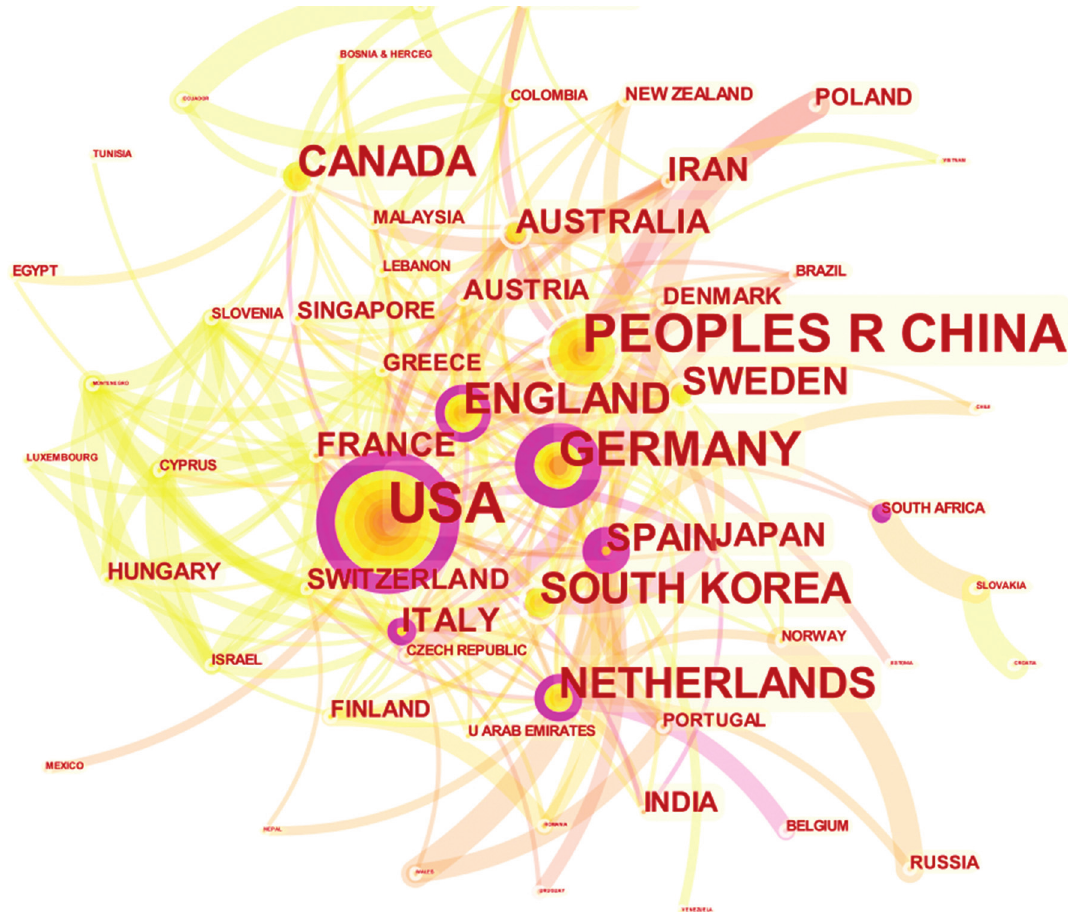
Figure 4: National collaboration